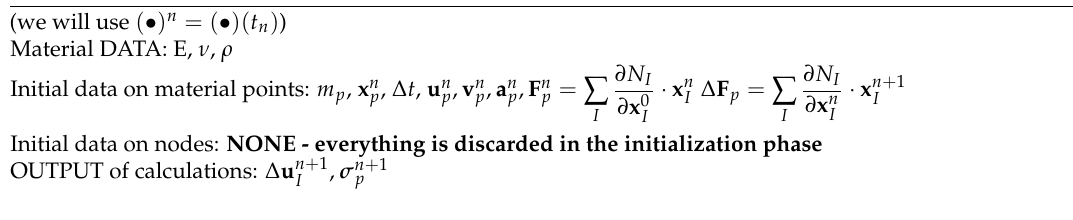
Algorithm 1 MPM